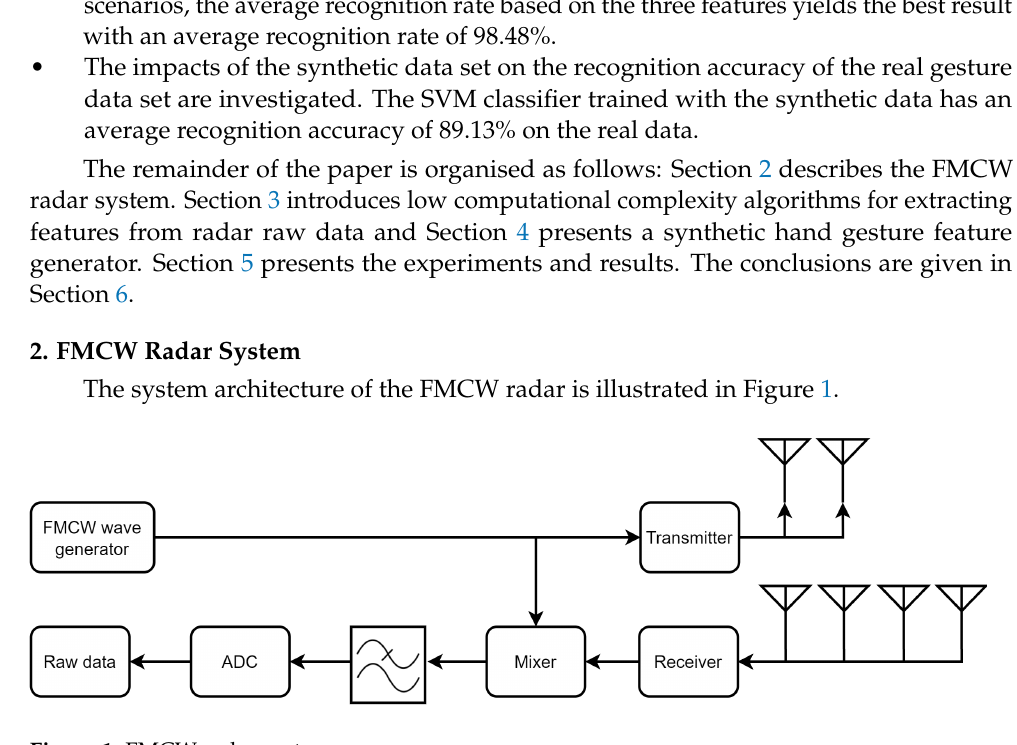
Figure 1. FMCW radar system.